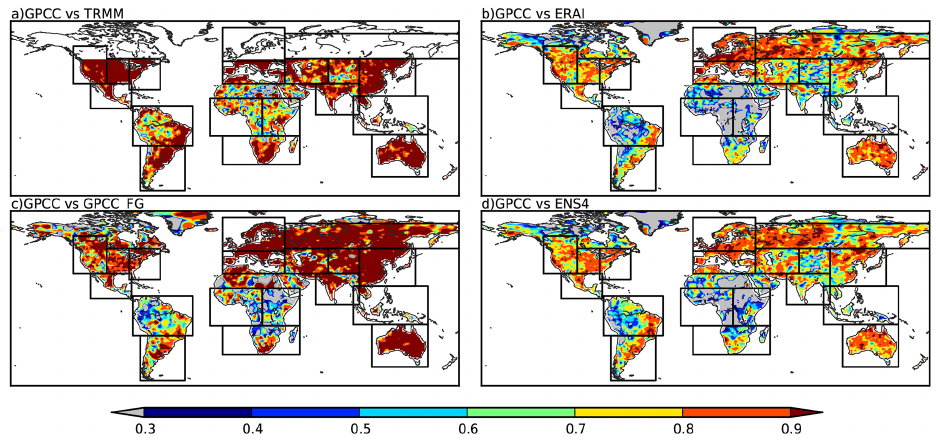
Figure 8. Temporal grid-point correlations of the GPCC monthly precipitation versus (a) TRMM, (b) ERAI, (c) GPCC_FG, and (d) ENS4. The correlations were calculated for the overlap period 2009–2012 and the mean annual cycle of the period was removed from each data set prior to the correlations calculation.